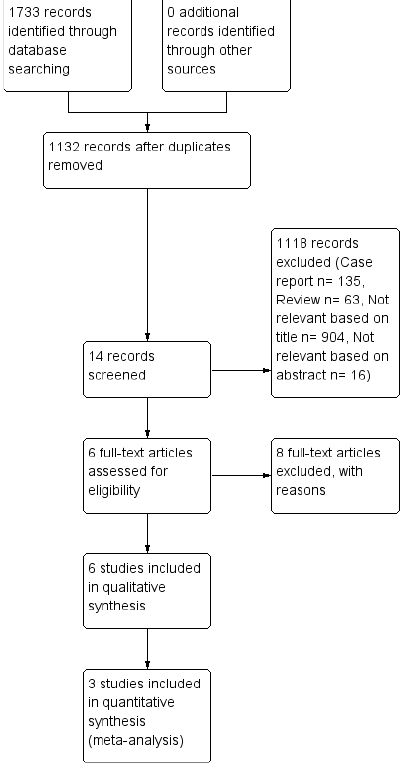
Figure 1. Flow chart of studies